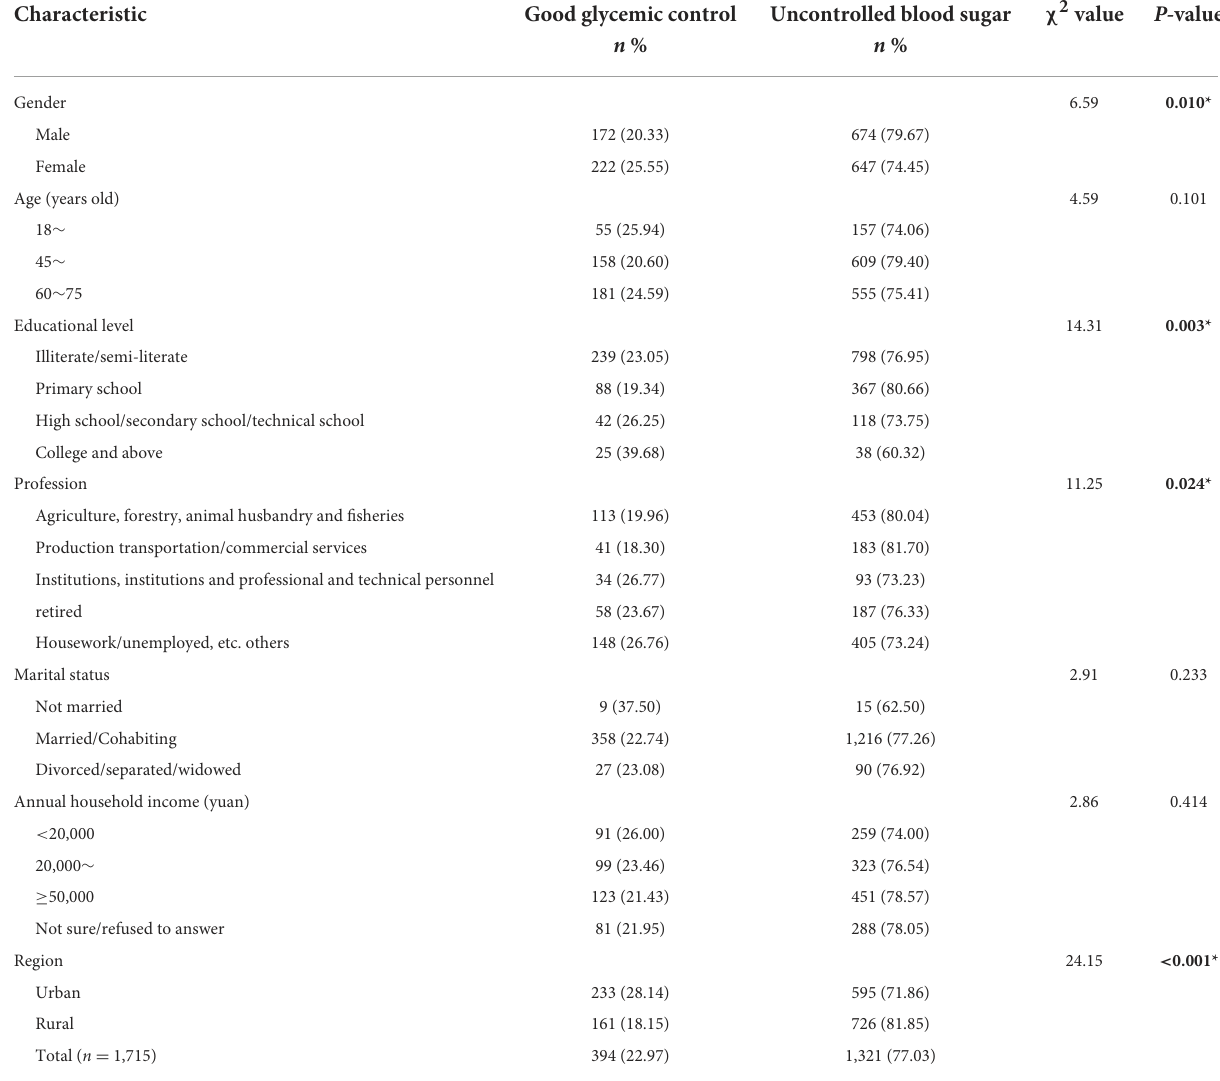
TABLE 1 The glycemic control of T2D patients with sociodemographic characteristics.